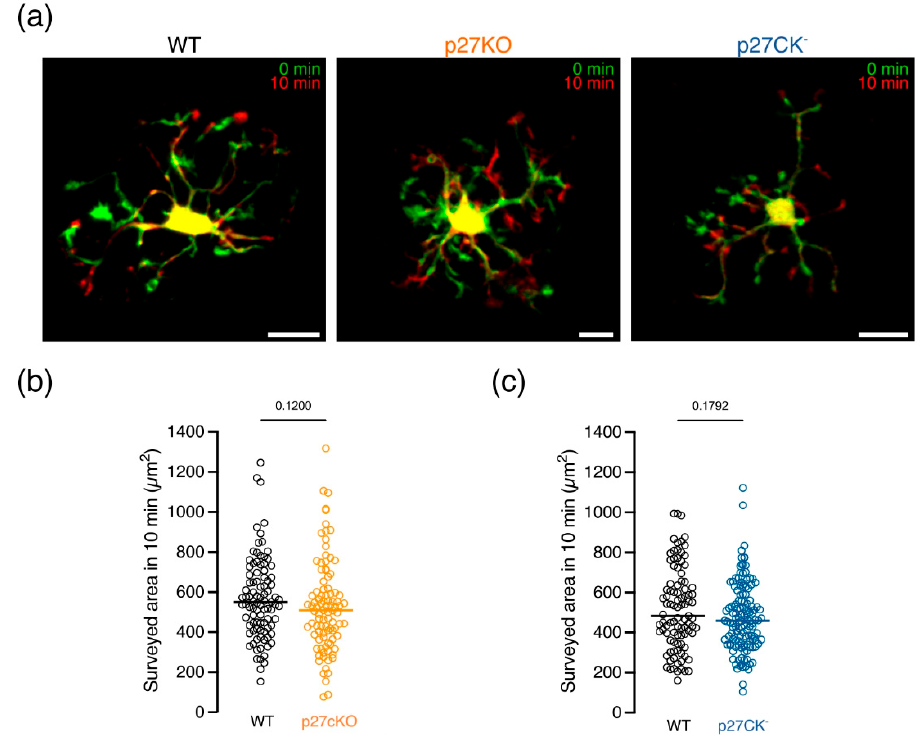
Figure 3. Microglial surveillance of the cortex does not involve p27. ( a ) Representative images showing microglial surveillance for CX3CR1 eGFP/+ p27WT, CX3CR1 eGFP/+ p27KO and CX3CR1 eGFP/+ p27CK − microglia. Images taken 10 min apart are overlaid to show microglial movement. ( b , c ) The surveyed area is not significantly different for p27KO ( b ) and p27CK − ( c ) microglia compared to p27WT cells. Data points represent individual microglia. Sample size ( b ) for p27WT: 93/8/3 (cells/brains/mothers); p27KO: 95/6/3. Sample size ( c ) for p27WT: 95/6/3; p27CK − : 135/8/3. Horizontal bars represent the median. Scale bar = 10 µm. Mann–Whitney U test.